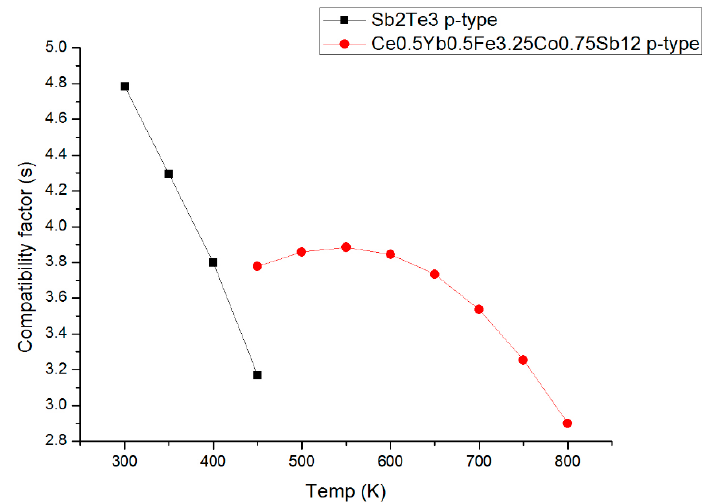
Figure 3. P-type compatibility factor of the materials.